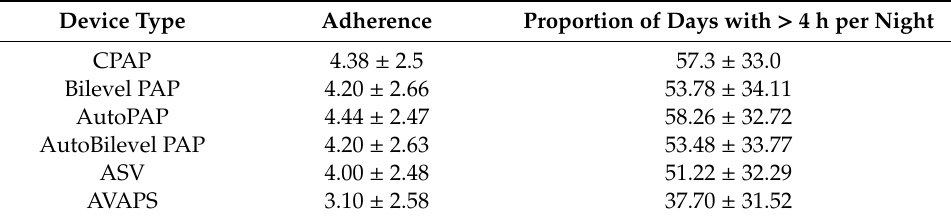
Table 3. Adherence by device type *.